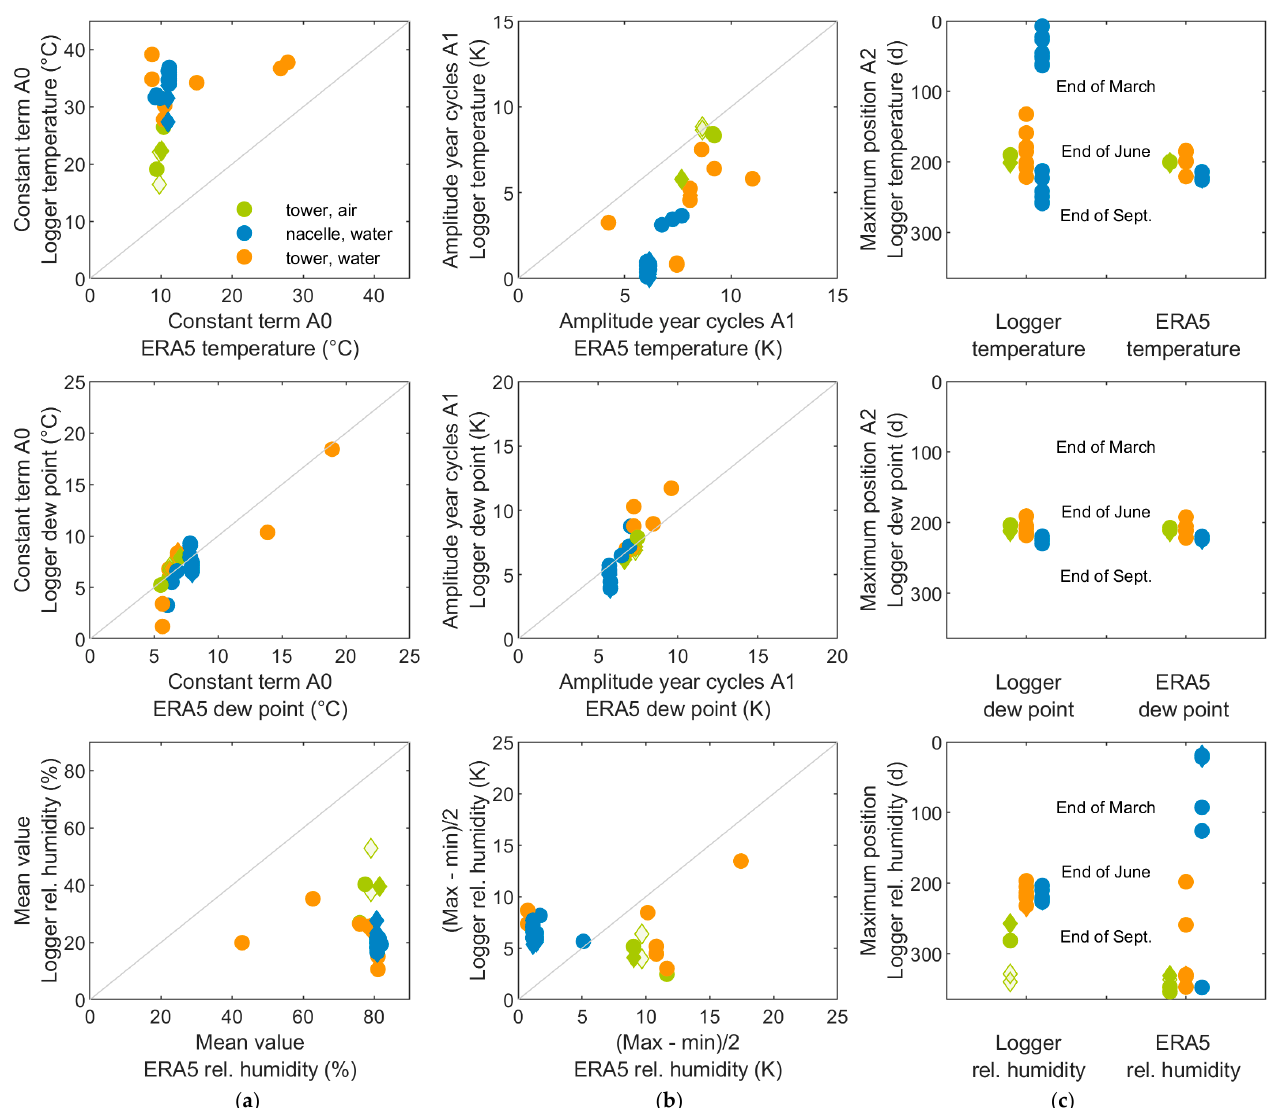
Figure 16. Scatterplots of parameters characterizing the climatic conditions inside the converter cabinet (“Logger”) and in the WT environment (“ERA5”) for WT with air-cooled converter in the tower base (green markers), WT with liquid-cooled converter in the tower base (orange markers) and WT with liquid-cooled converters in the nacelle (blue); scatterplots related to the constant term A 0 ( a ), to the amplitude of year cycles A 1 ( b ) and to the time of the year at which the maximum value is taken on ( c ).